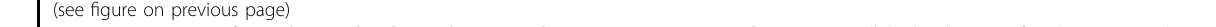
Fig. 5 Recruitment of signaling molecules and PIP3 production in IRS1-GFP condensates. a Cellular localization of mCherry-p85 with co- expressed GFP in U2OS cells. Scale bar, 10 μ m. b , c Cellular localization of IRS1-GFP co-expressed with mCherry-p85 ( b ) and mCherry-p110 ( c ) in response to insulin stimulation in U2OS cells. Scale bar, 10 μ m. Quanti fi cation of colocalization was shown in Supplementary Fig. S6. d – f Cellular localization of IRS1-GFP co-expressed with PIP2 sensor ( d ), mCherry-PDK1 ( e ), and mCherry-SIN1 ( f ) in response to insulin stimulation in HEK293T cells. Scale bar, 10 μ m. Quanti fi cation of colocalization was shown in Supplementary Fig. S6. g Cellular localization of IRS1-GFP co-expressed with PIP3 sensor in response to insulin stimulation. IRS1-GFP was expressed at low and high levels in U2OS cells. Scale bar, 10 μ m. Quanti fi cation of colocalization was shown in Supplementary Fig. S6. h Cellular localization of IRS1-GFP co-expressed with PKB β -mCherry in response to insulin stimulation. IRS1-GFP was expressed at low and high levels in Cos-7 cells. Arrows indicated PKB β -mCherry that was co-localized with IRS1 condensates upon insulin stimulation. Scale bar, 10 μ m. Quanti fi cation of colocalization was shown in Supplementary Fig.